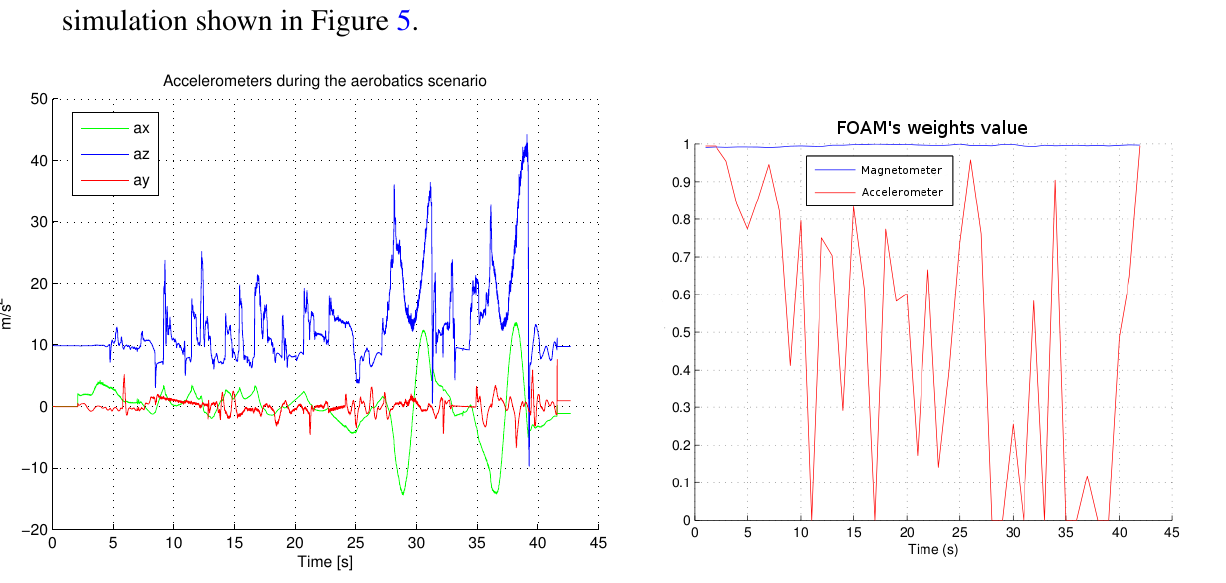
Figure 9. Accelerometers readings and evolution of the FOAM weights during the aerobatics simulation shown in Figure